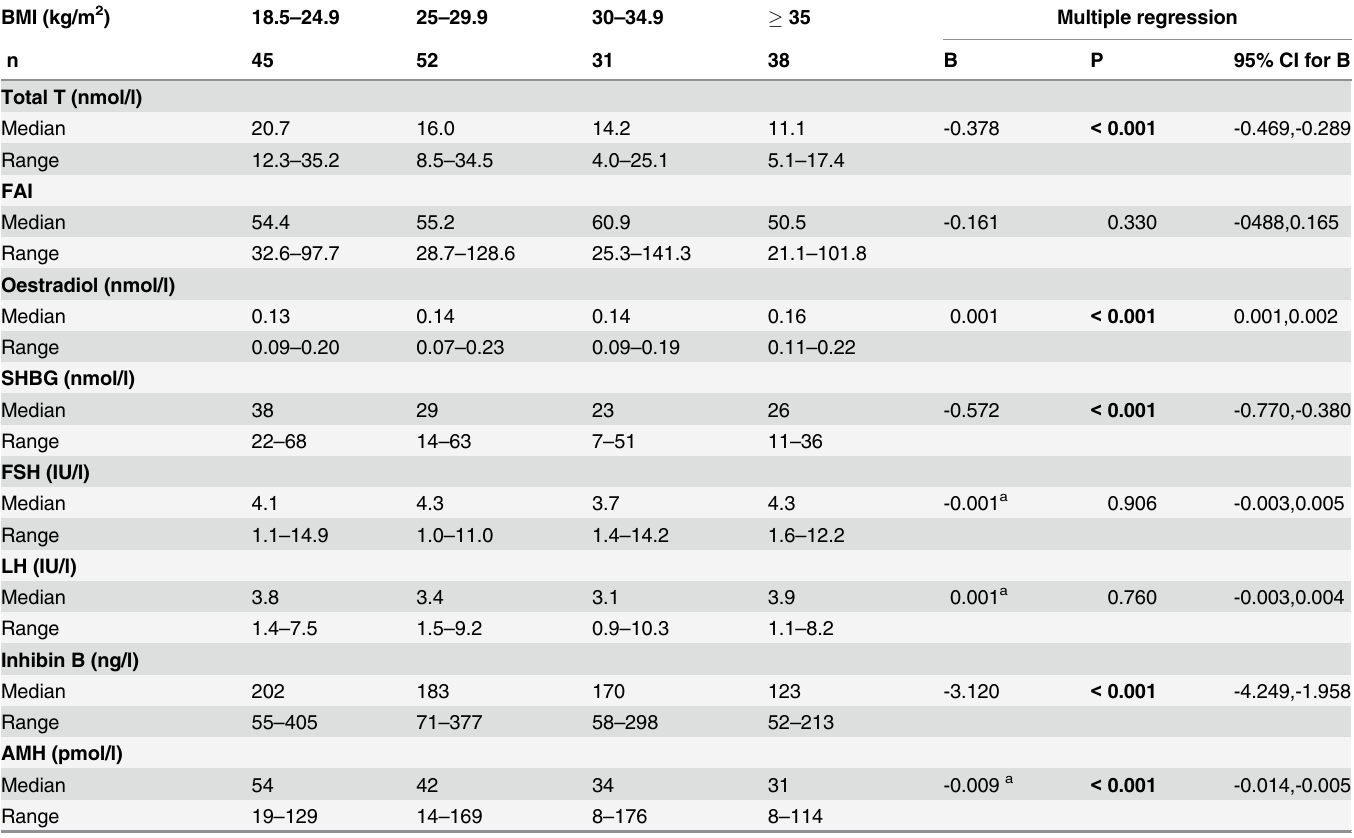
T, testosterone; FAI, free androgen index; SHBG, sex hormone binding globulin; FSH, follicle stimulating hormone; LH, luteinizing hormone; AMH, anti- Müllerian hormone; B, regression coef fi cient; CI, con fi dence interval. Associations tested by multiple linear regression were adjusted for age. All variables in the regression analyses were continuous variables. a , log transformed data.